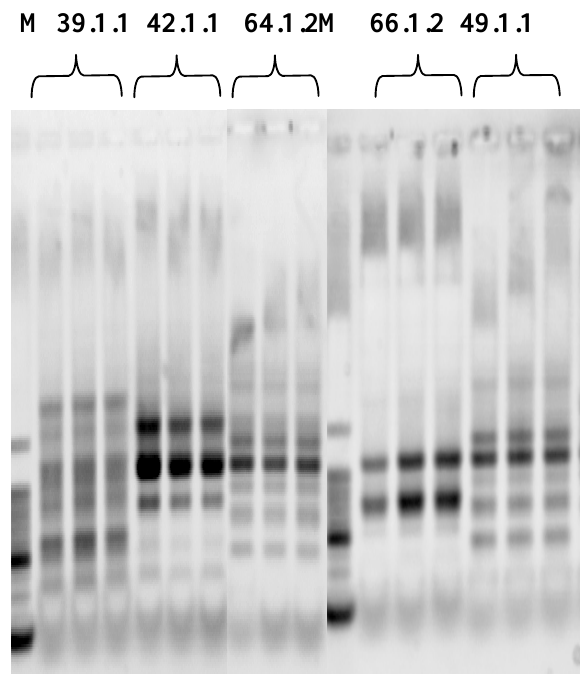
Figure 2: BOX-PCR agarose gel fingerprints run in triplicate from Enterococcus sp. isolates originating from deer. A HindIII digested Lambda marker was included in the gel run as a size standard 49.1.1 R1-3